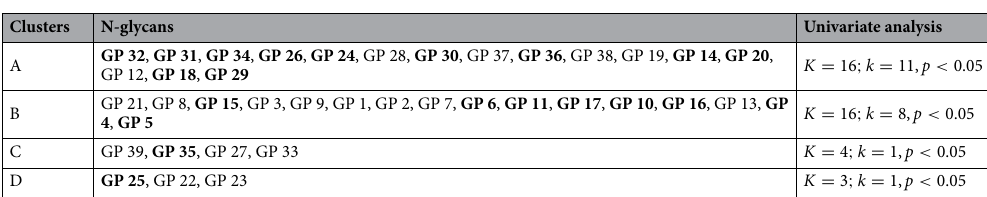
Table 1. Feature selection is important in the refinement of biological and biochemical hypotheses. We identified a combination of discriminative features from a disparate block of glycans. N-glycans loaded differently along the two principal components (PC), with estimates of positive and negative weights (Fig. 4). A large absolute value indicates the importance of the variable to the PC and the colour codes indicate how prominent the biomarker expressed in the cases of Type II diabetes mellitus and healthy controls. To discriminate between T2DM and healthy controls, the optimal model identified the N-glycans signatures and expressed their contributions in classifying between T2DM and healthy controls for 10 out of 39 N-glycans in each component. The top 10